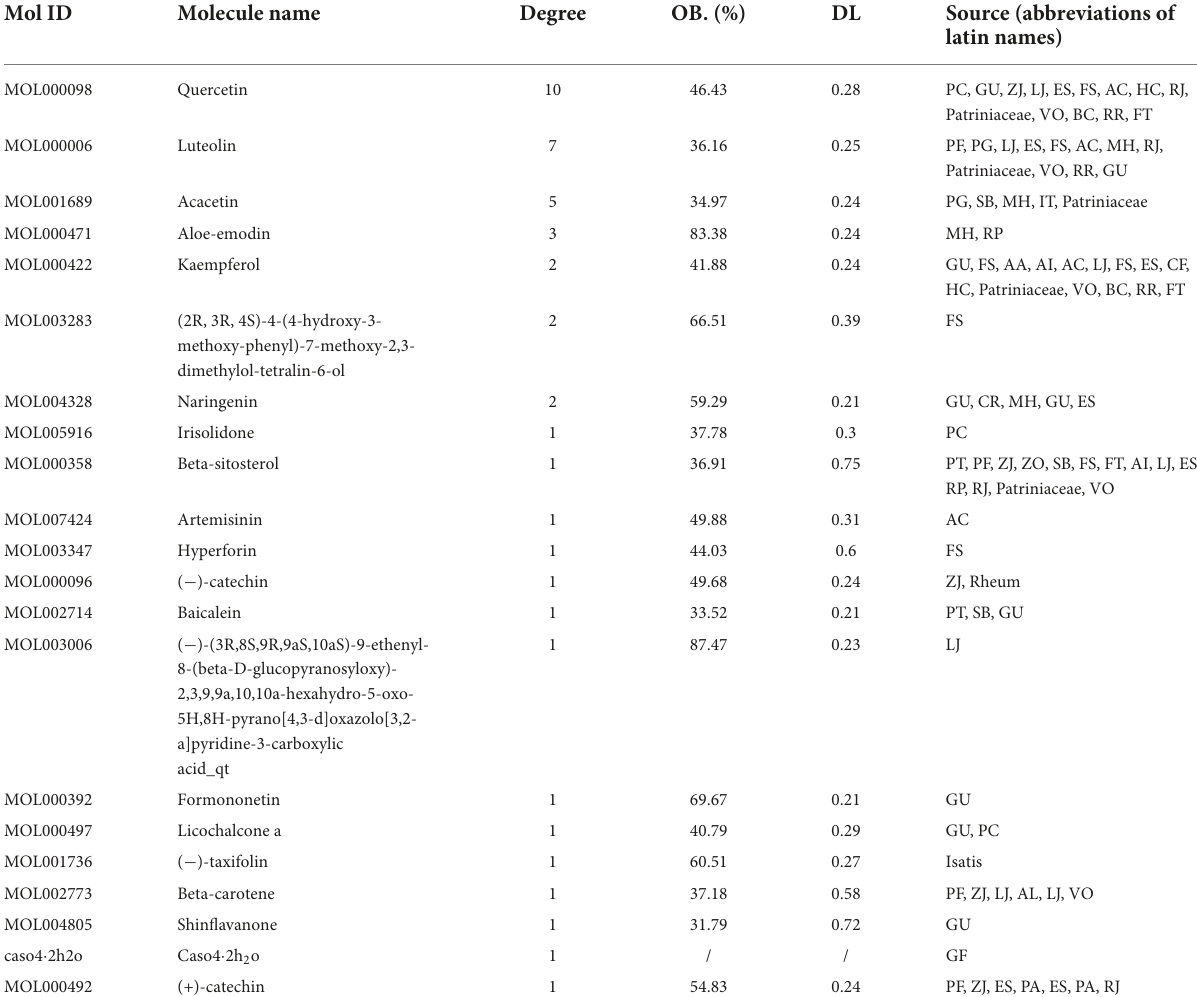
TABLE 6 Pharmacokinetics and sources of the top 21 key active ingredients. Mol ID Molecule name Degree OB. (%) DL Source (abbreviations of